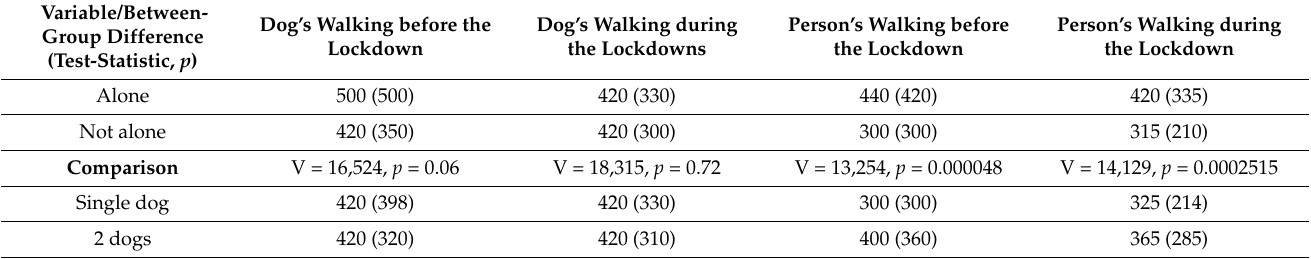
Table 3. Between group differences for duration of walks both before and during the lockdown are summarised with Mann–Whitney test-statistic where 2 categories were compared (V), K-W test-statistic (X 2 ) where 3 or more categories were compared and test significance levels ( p ). Where the between-group comparison was statistically significant ( p < 0.05), Dunn p values with further Benjamini–Hochberg FDR adjustment for multiple comparisons are